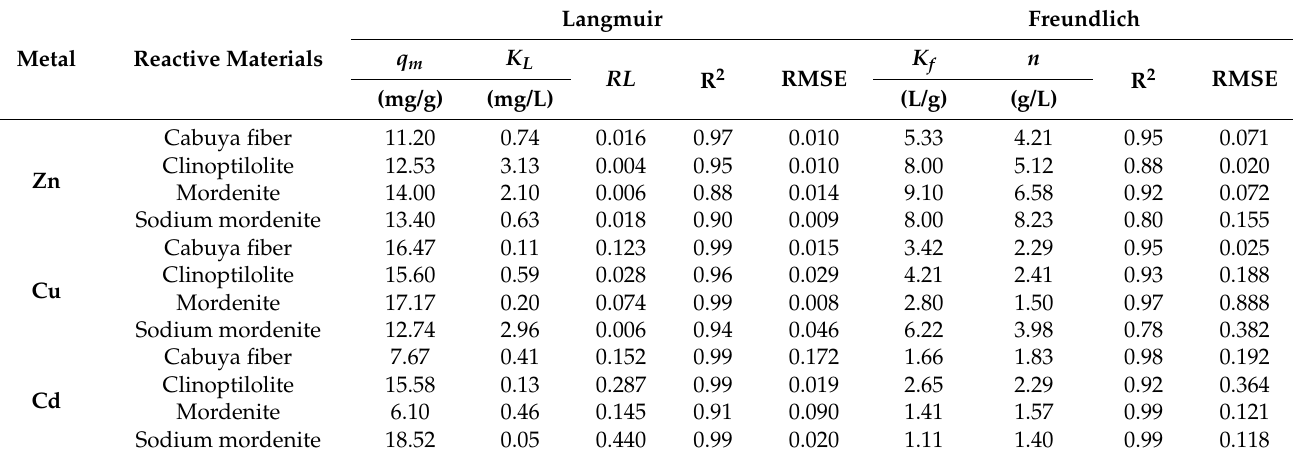
Table 4. Characteristic parameters of Langmuir and Freundlich